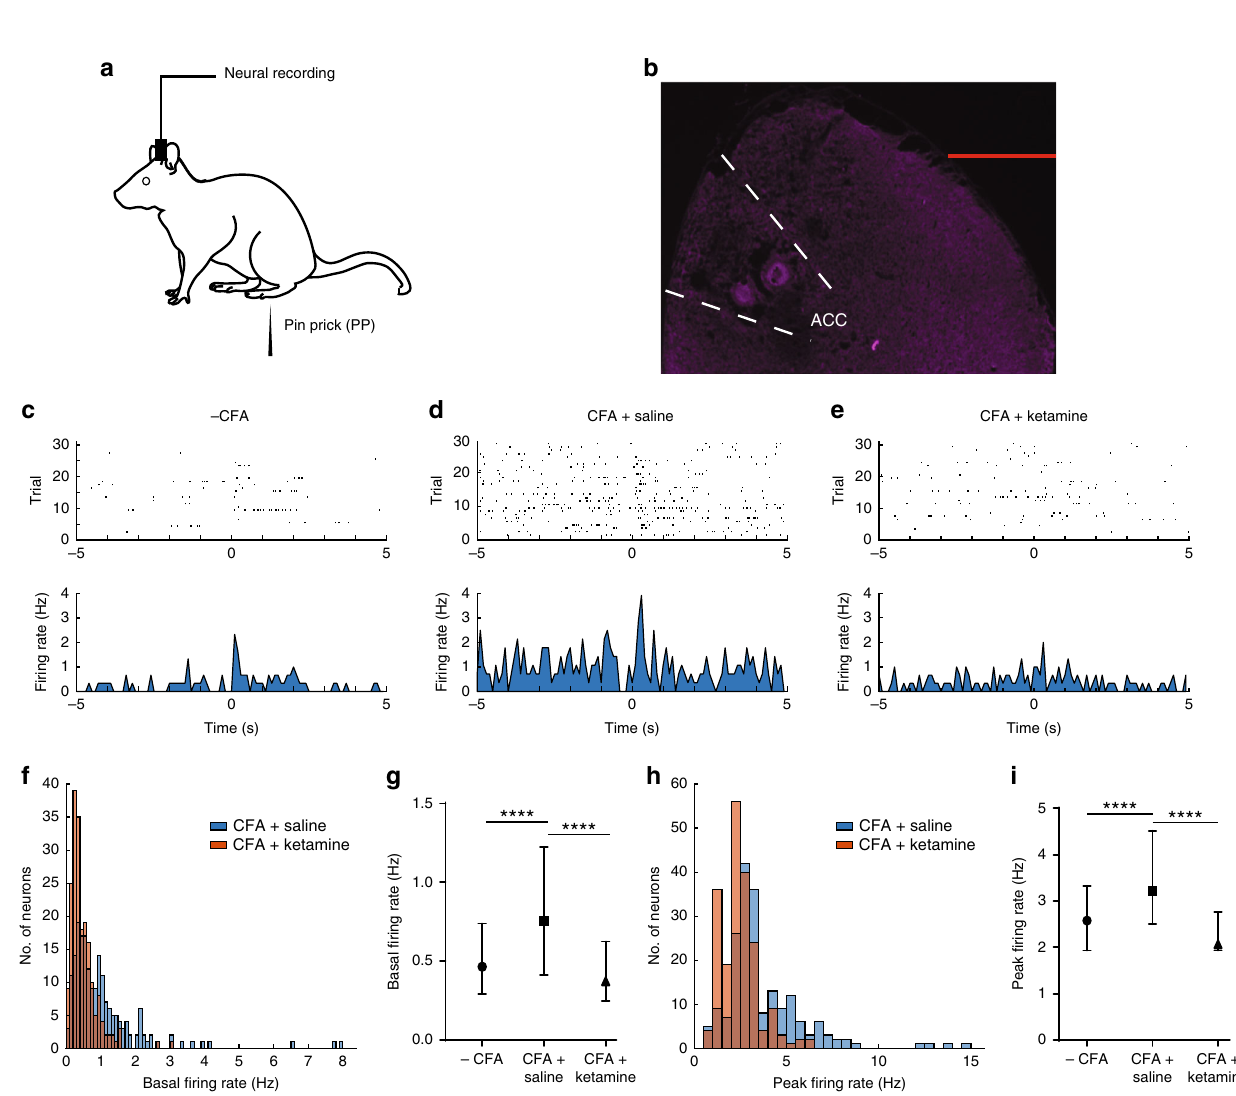
Fig. 5 Ketamine reduces hyperactivity of neurons in the ACC. a Experimental paradigm for electrophysiological recordings in free-moving rats. b Location of recording electrodes in the ACC. c Raster plots and peri-stimulus time histograms (PSTHs) of representative ACC neurons. Time 0 indicates the onset of noxious (PP) stimulation. d , e Raster plots and PSTHs for CFA-treated rats 5 days after receiving d saline or e ketamine infusion. f , g Chronic pain increased basal fi ring rates of ACC neurons, but ketamine treatment inhibited this increase. f Histogram showing the distribution of basal fi ring rates of neurons after saline or ketamine treatment in CFA-treated rats. g Median± interquartile range for basal fi ring rates in naive rats, and in CFA-treated rats after ketamine or saline injection; n = 201 ( − CFA), 195 ( + CFA and saline), and 200 ( + CFA and ketamine); p < 0.0001, Kruskal – Wallis test with post-hoc Dunn ’ s multiple comparisons. See Methods. h , i Ketamine inhibited the enhancement of pain-evoked fi ring rates of ACC neurons in CFA-treated rats; p < 0.0001. h Histogram showing the distribution of peak fi ring rates for neurons after saline or ketamine treatment in CFA-treated rats. i Median± interquartile range for pain-evoked fi ring rates in naive rats, and in CFA-treated rats after ketamine or saline injection; n = 201 ( − CFA), 195 ( + CFA and saline), and 200 ( + CFA and ketamine); p < 0.0001. Error bars represent S.E.M. Scale bar equals 1000 μ m in b . ∗∗∗∗ p <